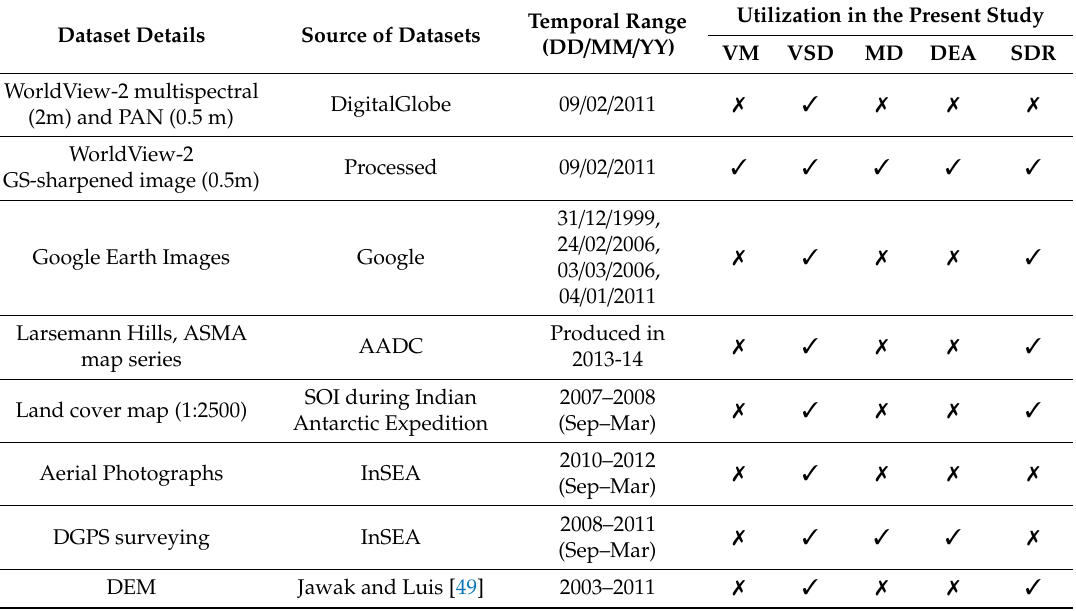
Table 1. A list of satellite and ground truth datasets and their usage status in the present study for e ff ective vegetation mapping. The potential usage of these datasets includes vegetation mapping (VM), visual interpretation and supplementing digitization (VSD), manual digitization (MD), digitization error analysis (DEA), shadow detection and removal (SDR). The notation (cid:51) ( (cid:55) ) denotes used (not used) in this